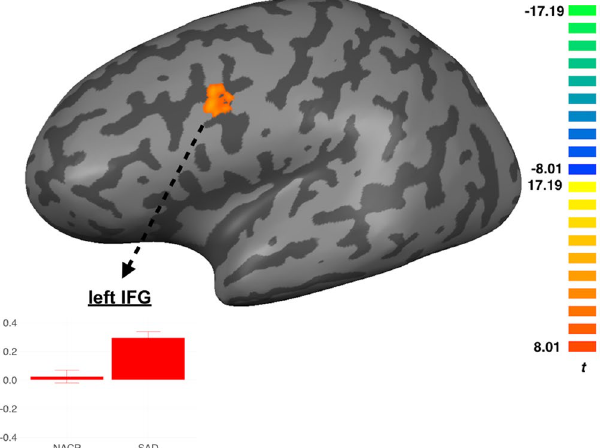
Figure 3. Group comparison for the re-inclusion contrast ( INCL2 – INCL1 ) between individuals qualifying for the diagnosis of social anxiety disorder (SAD) and matched nonanxious control participants (NACP). Threshold set at p < 0.001, p -values are corrected for multiple comparisons using a Monte-Carlo simulation (iterations = 10,000) cluster size threshold adjustment, with a minimum cluster size of 16 voxels for the two- sample t -tests. Beta-values for each group are presented in the bar plot. Error bars represent standard errors of the mean.